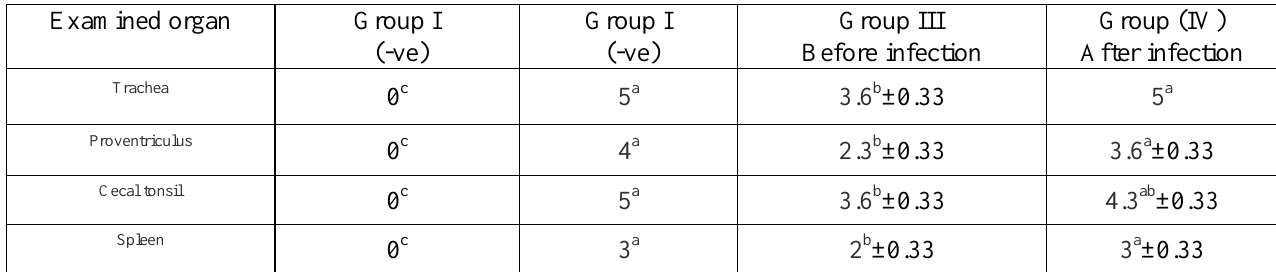
Table 7: Effect of 1 gm of ECV extract on histopathological lesion scores after VNDV challenge in Sasso chickens from different